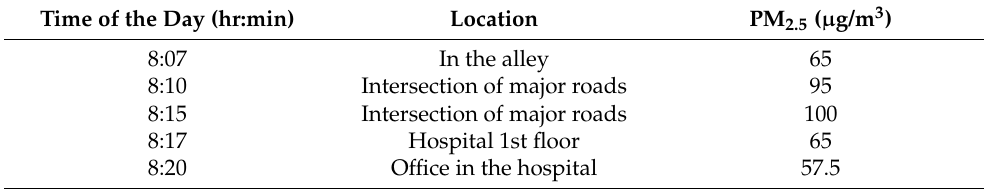
Table 1. An example of a short walk from home to work (hospital) on 10 April 2019.